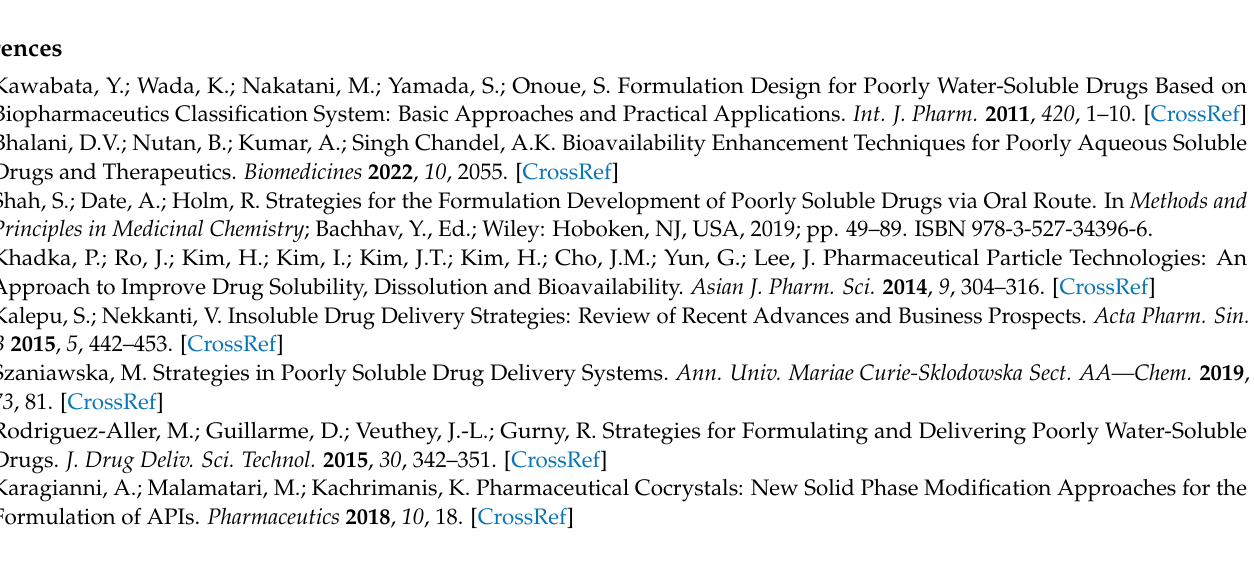
Figure S2: ( a ) PXRD recorded on a PANalytical 3 kW system in Bragg Brentano geometry and with a Cu K α ( λ = 1.5425 Å) source, ( b ) The DSC measurement. The first heating run from 0 ◦ C to 100 ◦ C (blue line), then a cooling run from 100 ◦ C to 0 ◦ C (green line), followed by a second heating run from 0 ◦ C to 100 ◦ C (red line), ( c ) VT NMR data 1 H MAS (left column) and 13 C CP MAS (right column) recorded with spinning rate of 12 kHz for a physical mixture of ET:EMA/SiO 2(hydr) ; Table S1: Cumulative release (%) of ET for all analyzed samples (water, pH 5.7); Table S2. Cumulative release (%) of ET for all analyzed samples (simulated gastric fluid without pepsin (SGFsp), pH